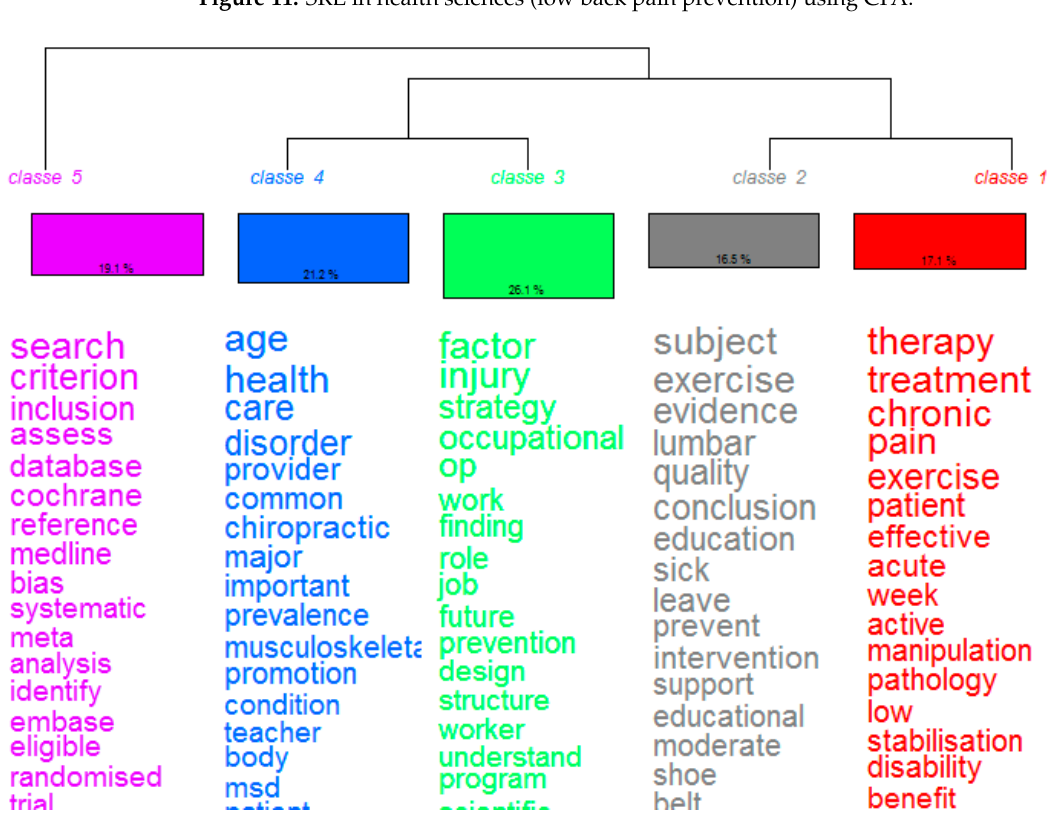
Figure 11. SRL in health sciences (low back pain prevention) using CFA.